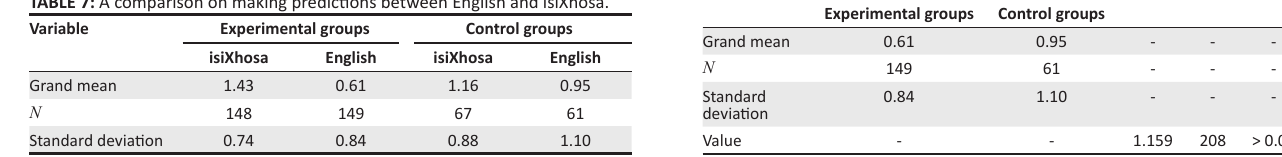
- TABLE 9: A comparison of the grand mean scores and p -value on the ability to make text prediction in English.